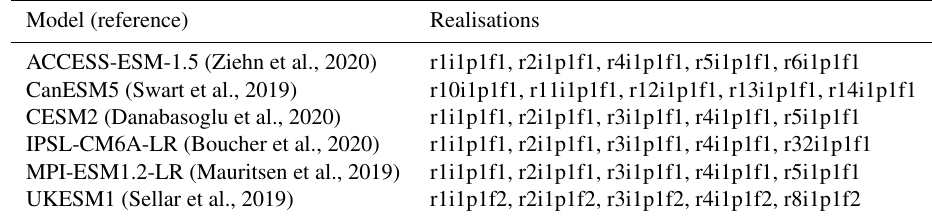
Table 1. CMIP6 Earth system models and realisations used for reconstruction. Model